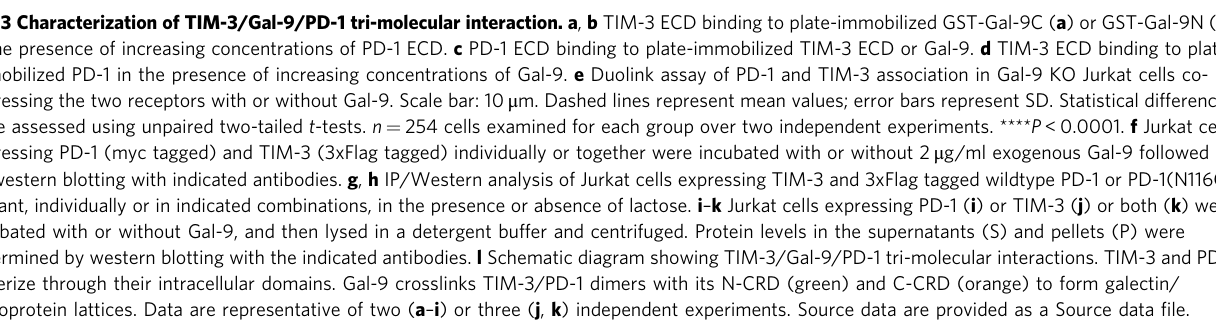
Fig. 3 Characterization of TIM-3/Gal-9/PD-1 tri-molecular interaction. a , b TIM-3 ECD binding to plate-immobilized GST-Gal-9C ( a ) or GST-Gal-9N ( b ) in the presence of increasing concentrations of PD-1 ECD. c PD-1 ECD binding to plate-immobilized TIM-3 ECD or Gal-9. d TIM-3 ECD binding to plate- immobilized PD-1 in the presence of increasing concentrations of Gal-9. e Duolink assay of PD-1 and TIM-3 association in Gal-9 KO Jurkat cells co- expressing the two receptors with or without Gal-9. Scale bar: 10 μ m. Dashed lines represent mean values; error bars represent SD. Statistical differences were assessed using unpaired two-tailed t -tests. n = 254 cells examined for each group over two independent experiments. **** P < 0.0001. f Jurkat cells expressing PD-1 (myc tagged) and TIM-3 (3xFlag tagged) individually or together were incubated with or without 2 μ g/ml exogenous Gal-9 followed by IP/western blotting with indicated antibodies. g , h IP/Western analysis of Jurkat cells expressing TIM-3 and 3xFlag tagged wildtype PD-1 or PD-1(N116Q) mutant, individually or in indicated combinations, in the presence or absence of lactose. i – k Jurkat cells expressing PD-1 ( i ) or TIM-3 ( j ) or both ( k ) were incubated with or without Gal-9, and then lysed in a detergent buffer and centrifuged. Protein levels in the supernatants (S) and pellets (P) were determined by western blotting with the indicated antibodies. l Schematic diagram showing TIM-3/Gal-9/PD-1 tri-molecular interactions. TIM-3 and PD-1 dimerize through their intracellular domains. Gal-9 crosslinks TIM-3/PD-1 dimers with its N-CRD (green) and C-CRD (orange) to form galectin/ glycoprotein lattices. Data are representative of two ( a – i ) or three ( j , k ) independent experiments. Source data are provided as a Source data fi